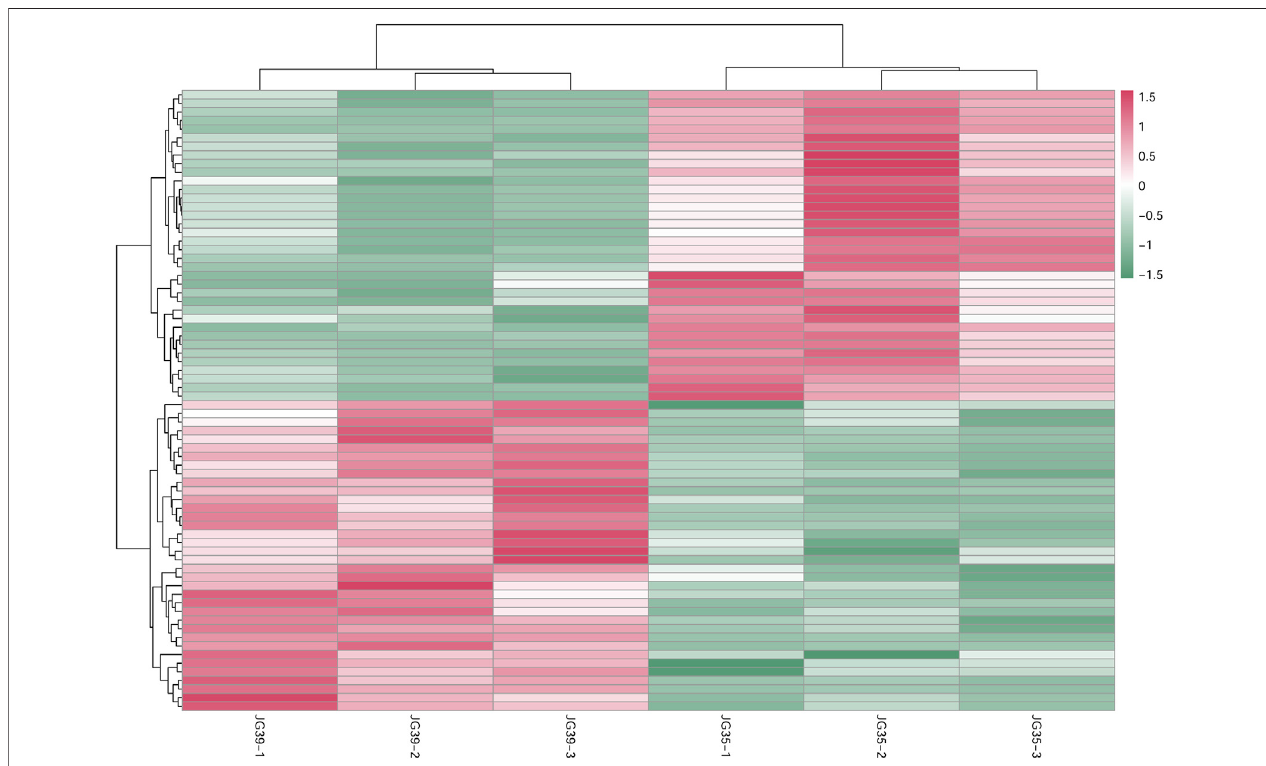
FIGURE 6 | Cluster diagram of differential lipid metabolism between JG35 and